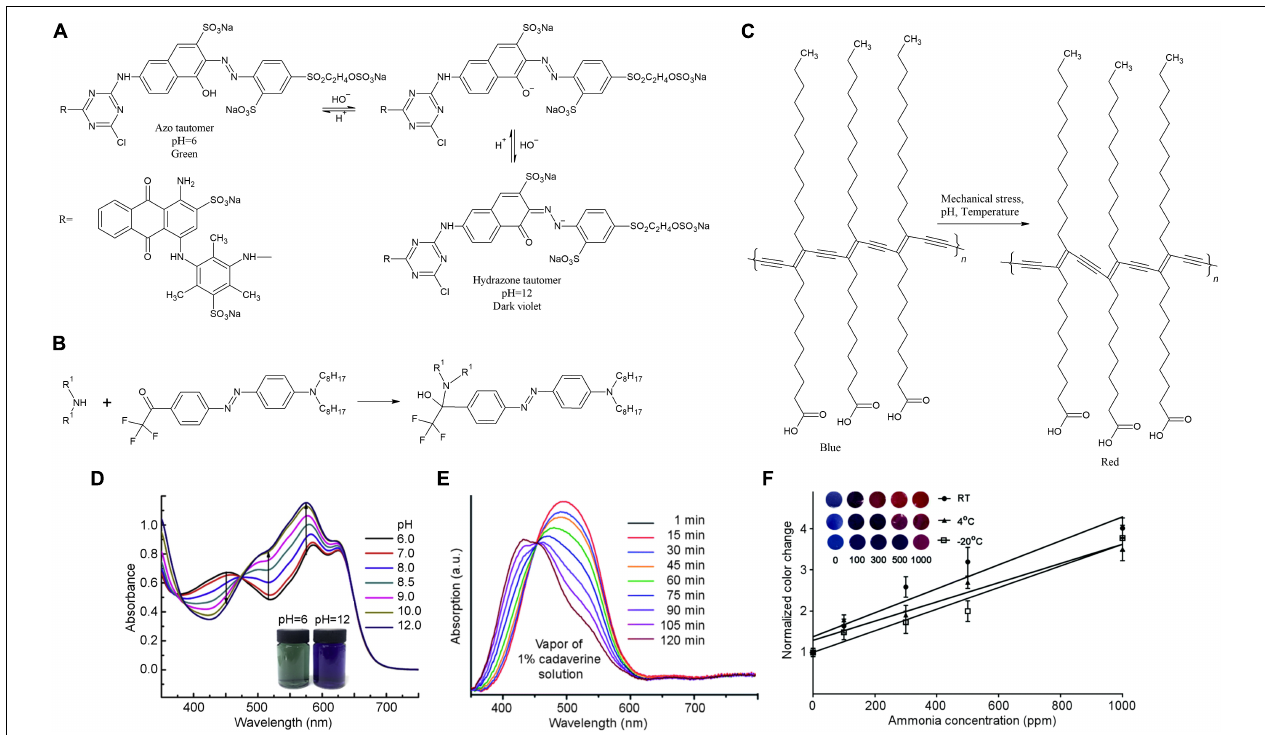
FIGURE 5 | Reaction mechanisms of (A) anthraquinone and (B) trifluoroacetyl azo dyes and (C) polymerized self-assembled polydiacetylene vesicles and the corresponding color change during analyte sensing as displayed in panels (D–F) , respectively. Note, that the normalized color change in panel (F) is the ratio of red and blue components in the RGB coordinates in reference to the original values. [ (A,D) Reprinted from Sens. Actuat. B 286, Zhang et al. (2019) Copyright (2020), with permission from Elsevier. (B,E) Reproduced from Lin et al. (2015). (C,F) Reproduced from Nquyen et al. (2019) with permission from The Royal Society of Chemistry.].